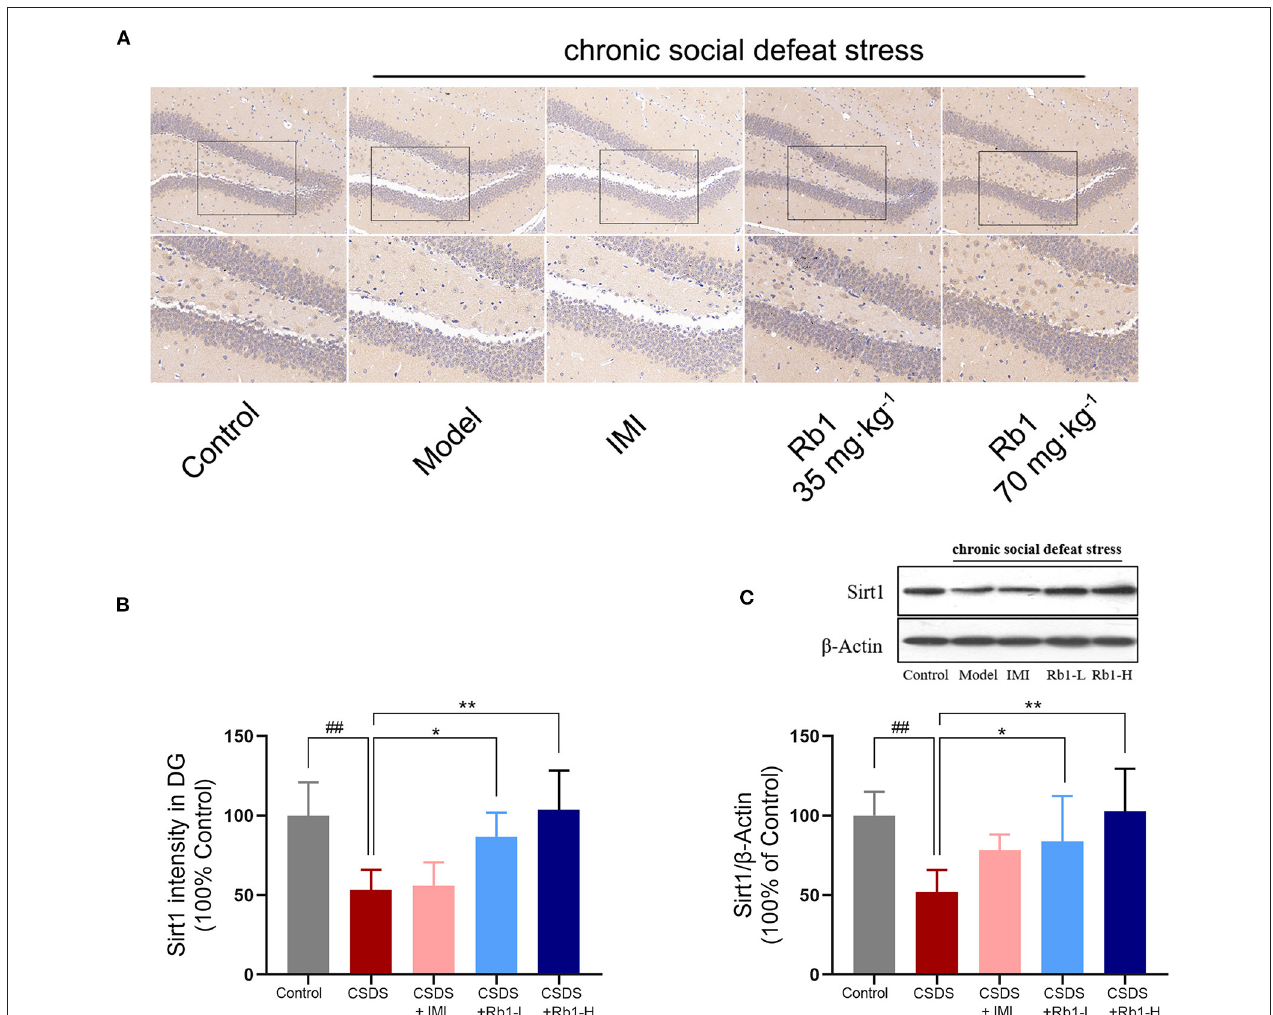
FIGURE 4 | In CSDS mice, ginsenosides Rb1 increased SIRT1 expression in the hippocampus. (A) SIRT1 expression in the rat hippocampal DG area, as seen by IHC staining. region (200, bar = 100 µ m; 400, bar = 50 µ m); (B) The mean fluorescence intensities of SIRT1 in the DG region; (C) Western blotting for detecting the SIRT1 expression in the hippocampus. The entire data has been presented are means ± SEM; N = 4 mice per group. ## p < 0.01, considerably varied from control; * p and ** p < 0.05, and 0.01, considerably varied from CSDS